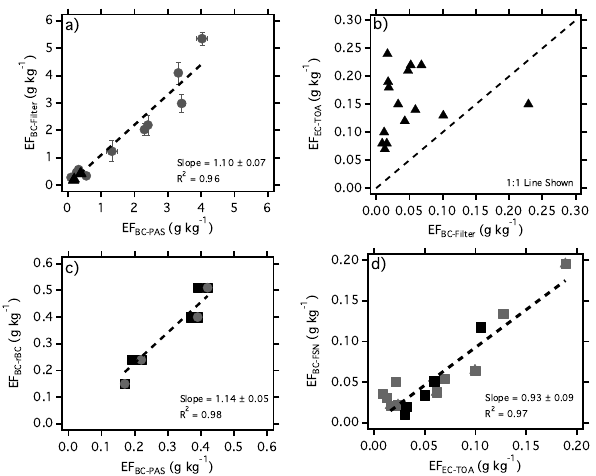
Fig. 1. Comparison of emission factors from marine diesel engines. (a) EF BC-PAS and EF BC-Filter from Lack et al. (2009) (circles) and Cappa et al. (2012) (triangles), (b) EF BC-Filter and EF EC-TOA from Petzold et al. (2011a), (c) EFBC-rBC and EFBC-PAS from Cappa et al. (2012) and (d) EF EC-TOA and EF BC-FSN from Ristimaki et al. (2010). Linear regression fit shown by dashed line in (a) , (c) and (d) . 1:1 line shown by dashed line in (b)